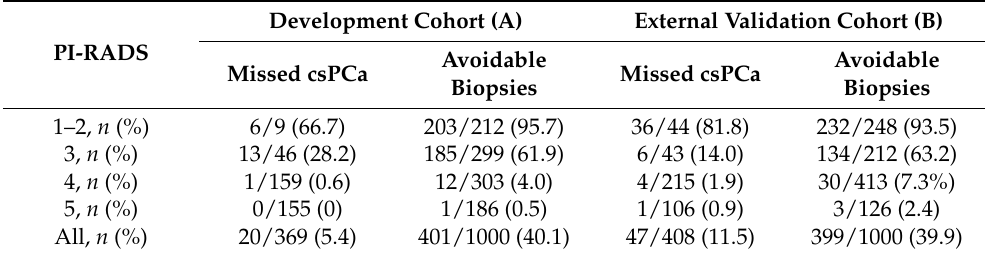
Table 4. Clinical utility of MRI-based predictive model in terms of avoidable prostate biopsies and potentially missed csPCa in a 1000-sample-size development cohort (A) and external validation cohort (B), using the 15% threshold and regarding PI-RADS categories.